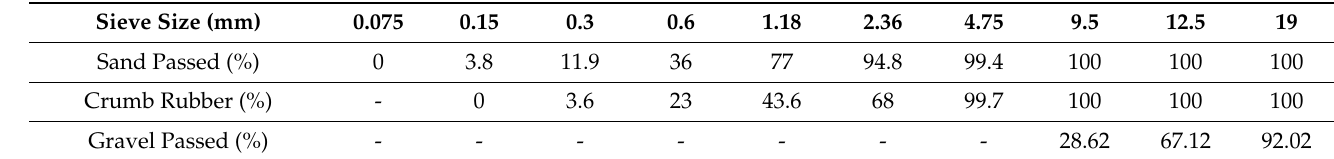
Table 2. Sieve analysis of